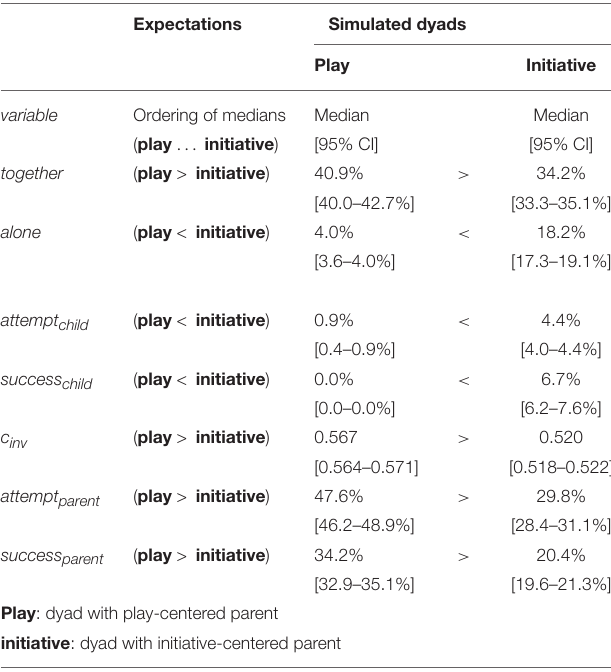
TABLE 2 | Comparison of the two simulated parent-child dyads in terms of our expectations for the relative ordering of the medians, across 2,000 simulated play